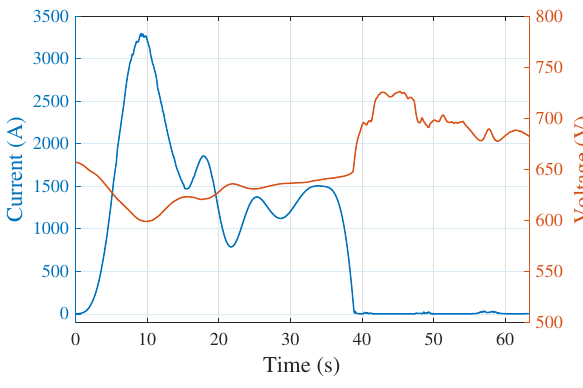
Figure 13. Substation1 Current and Voltage profiles without